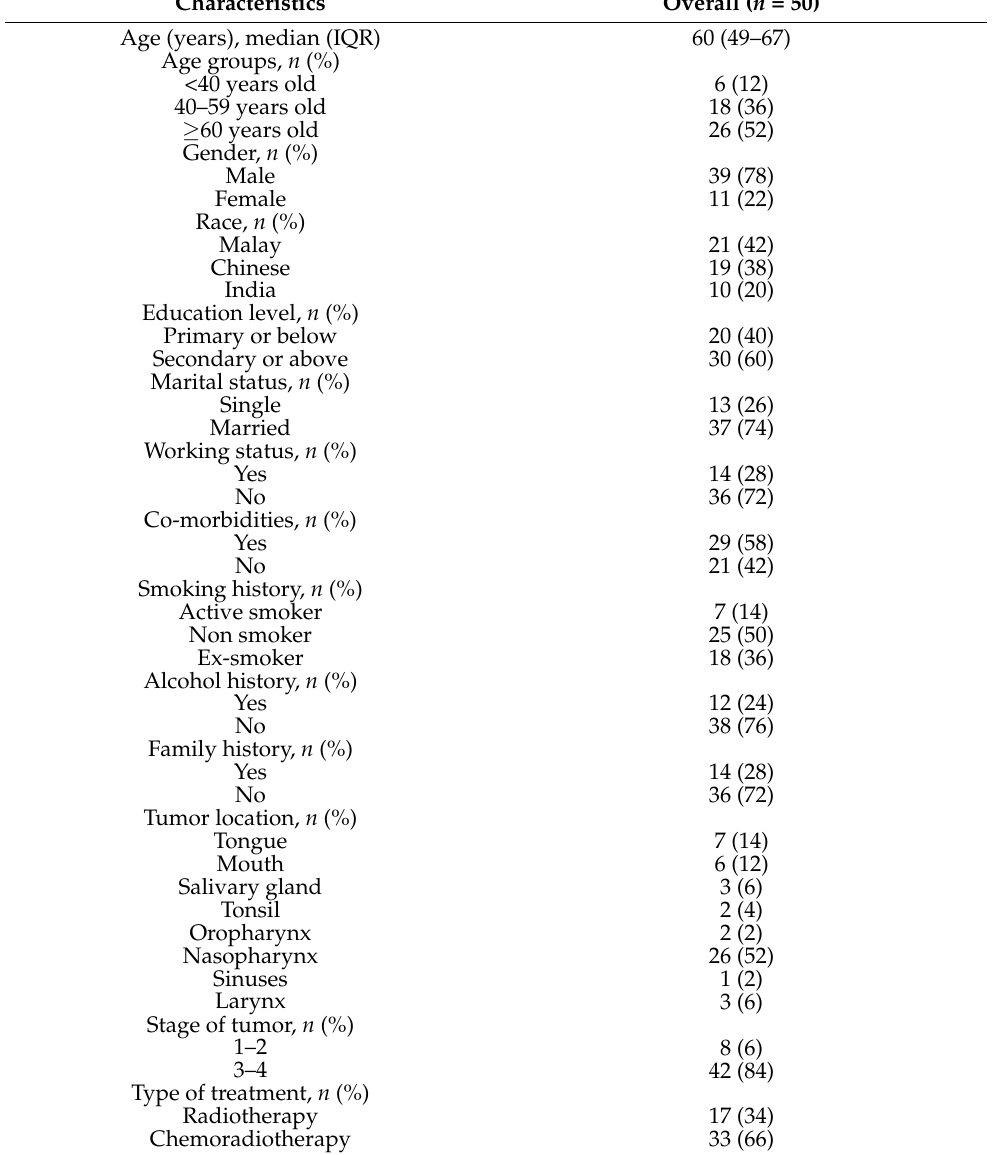
Table 1. Patient socio-demographics, clinical characteristics, lifestyle habits and types of